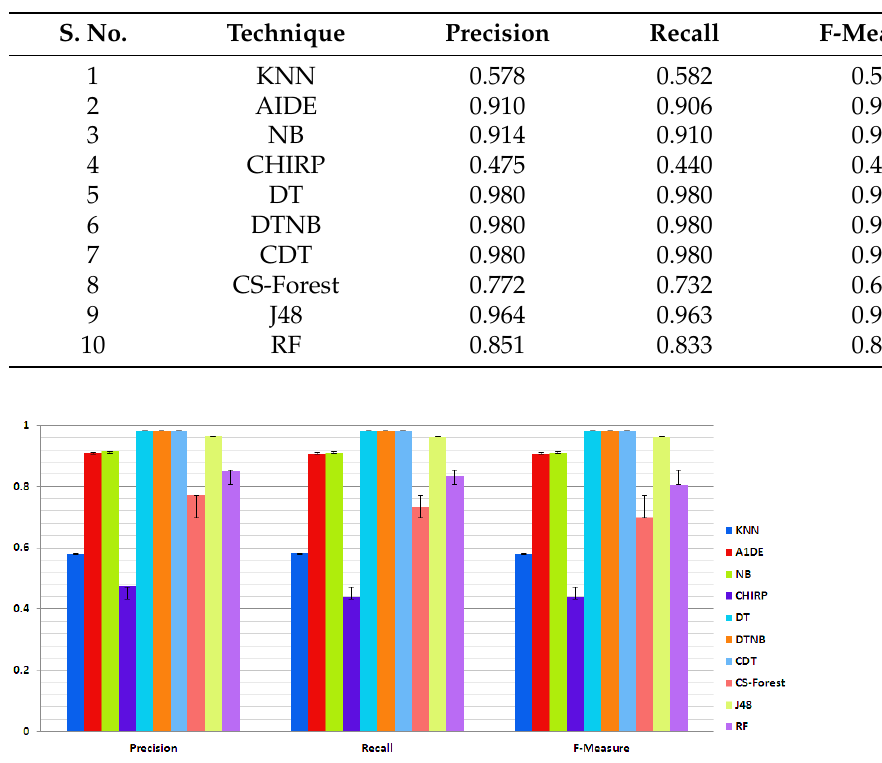
Table 26. Precision, Recall and F-Measure analysis of each employed technique.